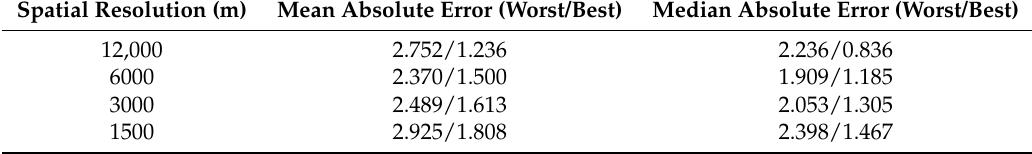
Table 5. MAE and MDAE of the worst (1988) and best model fit (1990) in four resolutions. Spatial Resolution (m) Mean Absolute Error